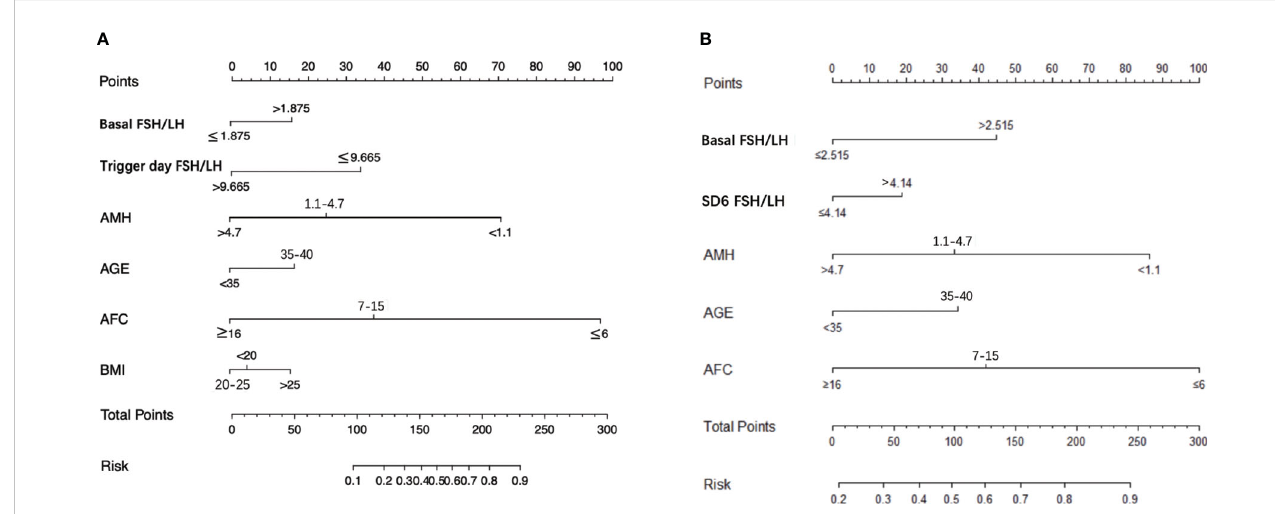
FIGURE 3 Nomogram graph to predict poor responder or poor reproductive potential for patients underwent IVF-ET. (A) obtained ≤ 5 oocytes, (B) obtained ≤ 3 available embryos during the cycle. AMH, anti-Mullerian hormone; BMI, body mass index; AFC, antral follicles count; SD6, Stimulation Day